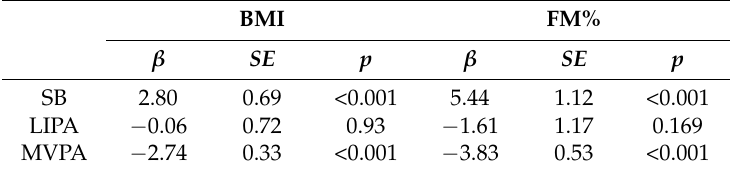
Table 3. LS regression estimates for adjusted compositional models. BMI FM% β SE